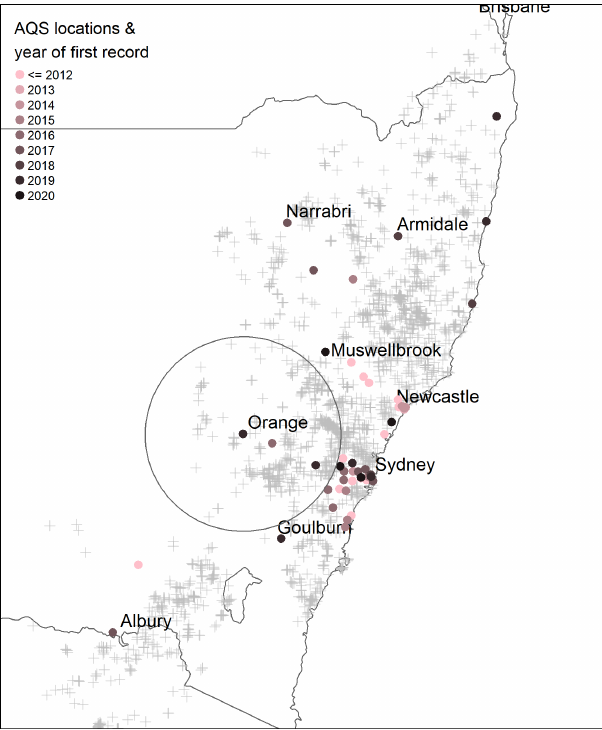
Figure 1. Map of the study area (New South Wales, Australia) showing air quality monitoring stations (AQSs, n = 48), coloured by year of first PM 2 . 5 record. Grey crosses are the locations of all fires used in analysis, with one cross per fire per day. The 150km buffer is shown around Orange AQS as an example (all AQSs had 150km buffers for